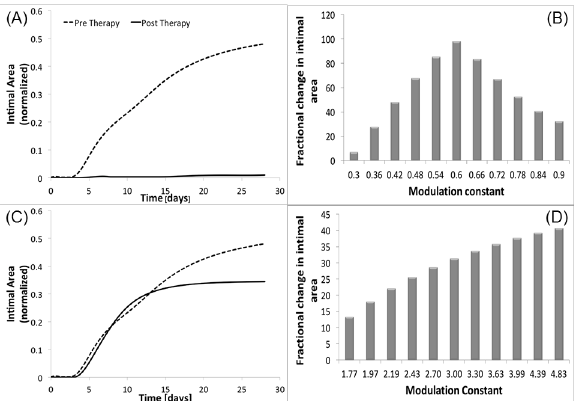
Fig 13. Gene therapy: Single cluster modulation. Reductionof intimal area recordedby singularly modulating cluster C (panelA) and cluster D (panelC). The correspondingsensitivity analysesare clusters C and D provided(panelB and D,